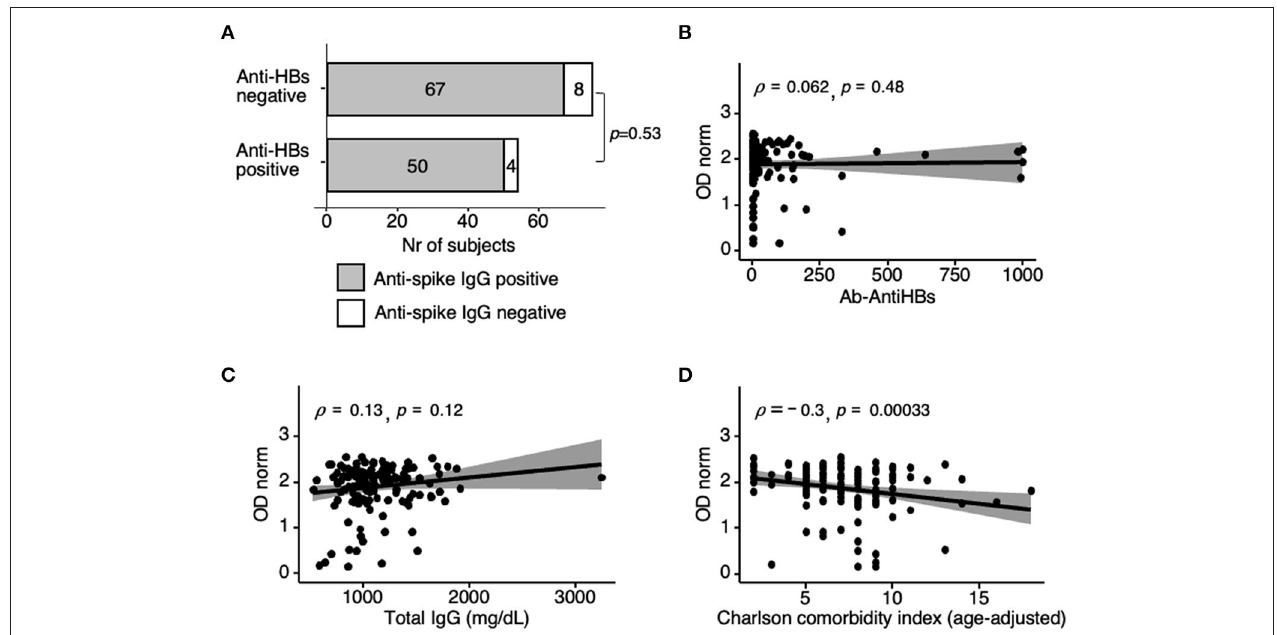
FIGURE 5 | Correlation analysis of anti-spike IgG responses at t2. (A) Anti-spike positivity as in Figure 2 , now in n = 75 non-responders and n = 54 responders to previous hepatitis B vaccination (anti-HBs antibody cut-off > 10 mIU/ml). Fischer’s test p -value = 0.53; OR = 1.49, 95%CI [0.48–4.65]. Fourteen anti-HBc reactive participants (i.e., previously infected with HBV) were excluded. (B) Spearman correlation coefficients ( ρ ) analysis of anti-spike IgG with anti-HBs antibody levels in anti HBc non-reactive individuals ( n = 129, same as in A ). (C,D) Spearman correlation coefficients ( ρ ) analysis of anti-spike IgG levels with total serum IgG also determined at t2 ( n = 142) (C) , and with age-adjusted Charlson-comorbidity index ( n = 142) (D) . Shaded areas represent 95% confidence interval. Differences were determined by Spearman’s rank-order non-parametric test; t2, sera collected 42 days post-first vaccine dose.